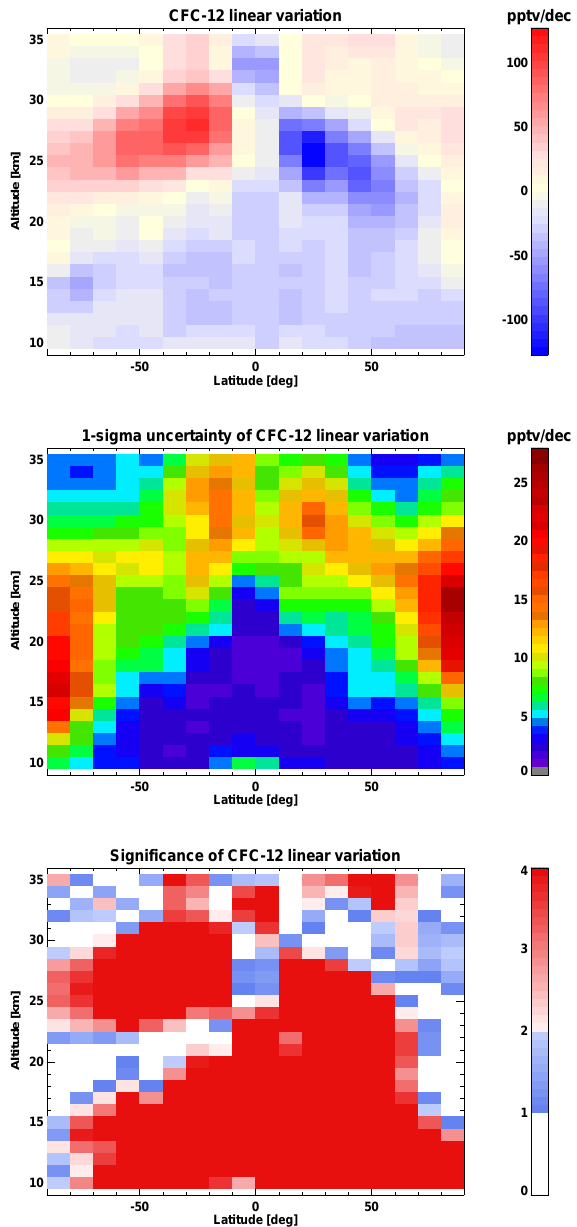
Fig. 15. CFC-12 trends over the years 2002 to 2011 as a function of altitude and latitude in pptv per decade (top); 1-sigma trend uncer- tainties (middle); and significance of the trend in terms of multiples of sigma (bottom). Numerical values are found in the Supplement.